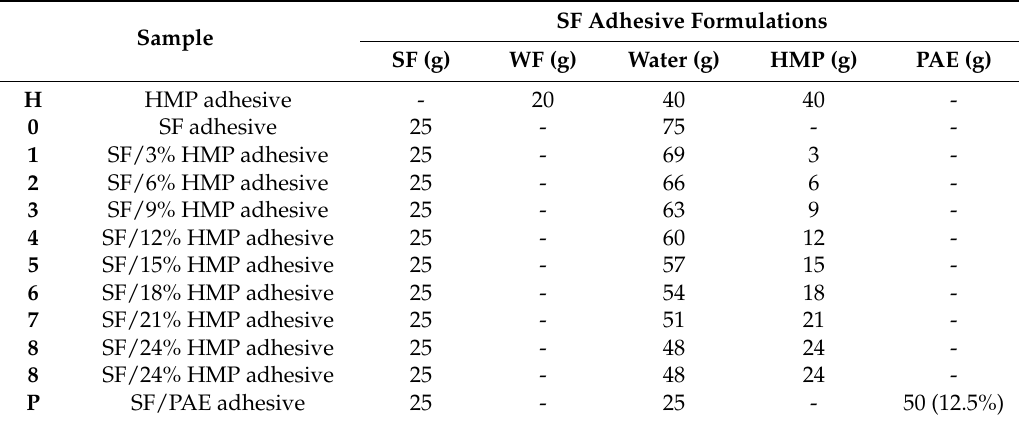
Table 1. Various soy flour (SF) adhesive formulations.